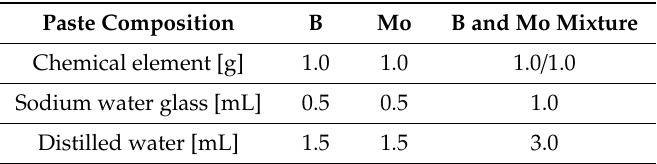
Table 2 . Composition of pre-coat pastes . Table 2. Composition of pre-coat pastes.